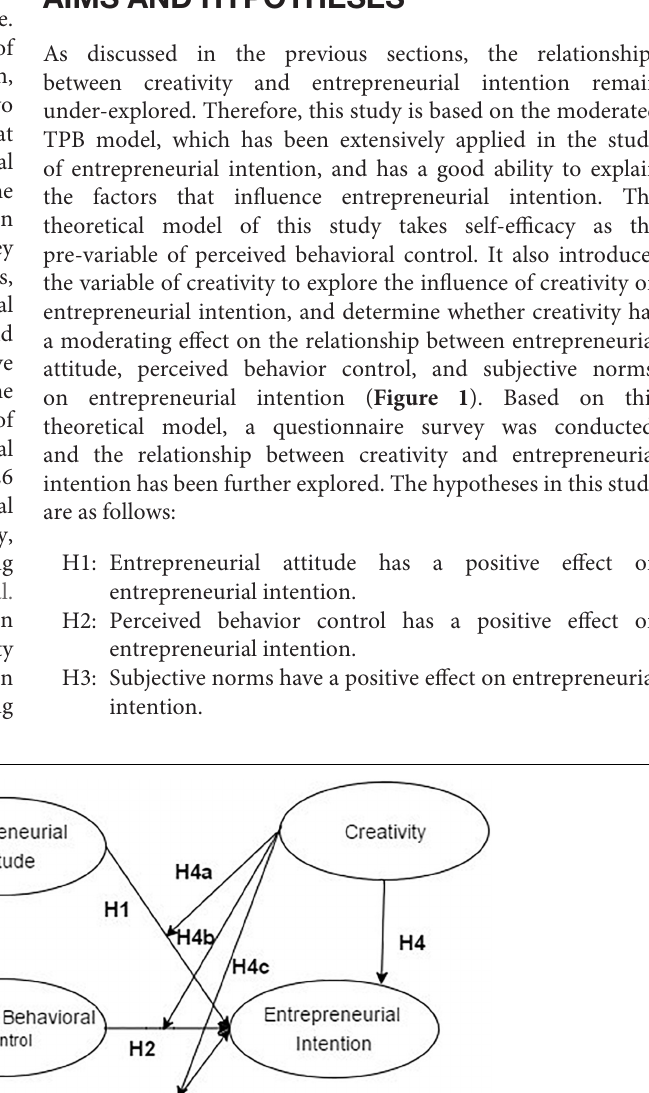
Frontiers in Psychology |